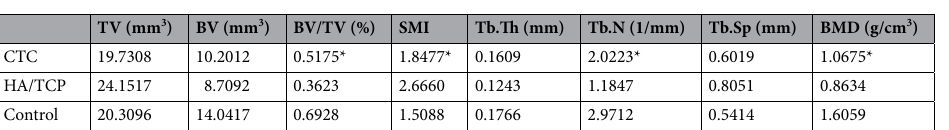
Table 1. The parameters of osteogenesis in bone repair. The control refers to the unoperated lateral tibia. TV tissue volume, BV bone volume, BV/TV bone volume fraction, SMI structure model index, Tb.Th trabecular thickness, Tb.N trabecular number, Tb.Sp trabecular number, BMD bone mineral density. The comparison between CTC and HA/TCP, * P <